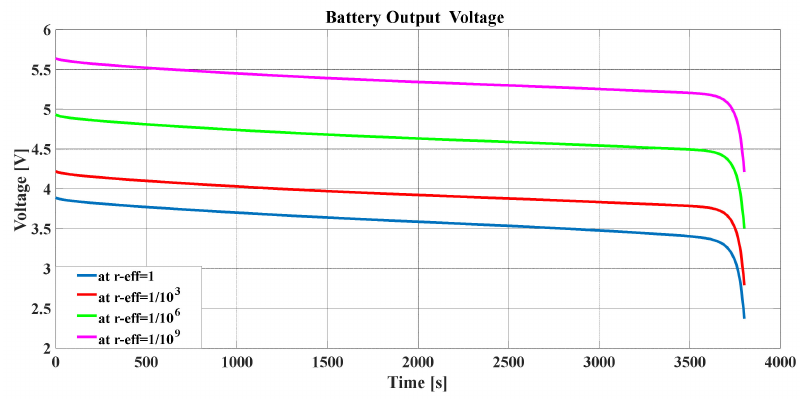
Figure 18. The battery discharging voltage at di ff erent values of r ef f